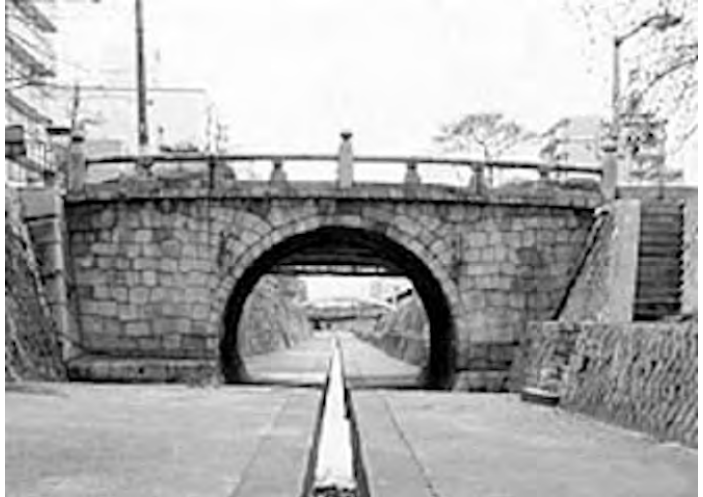
Figure 3. Horikawa canal during the early 1990s Source: Kyoto City Official Website